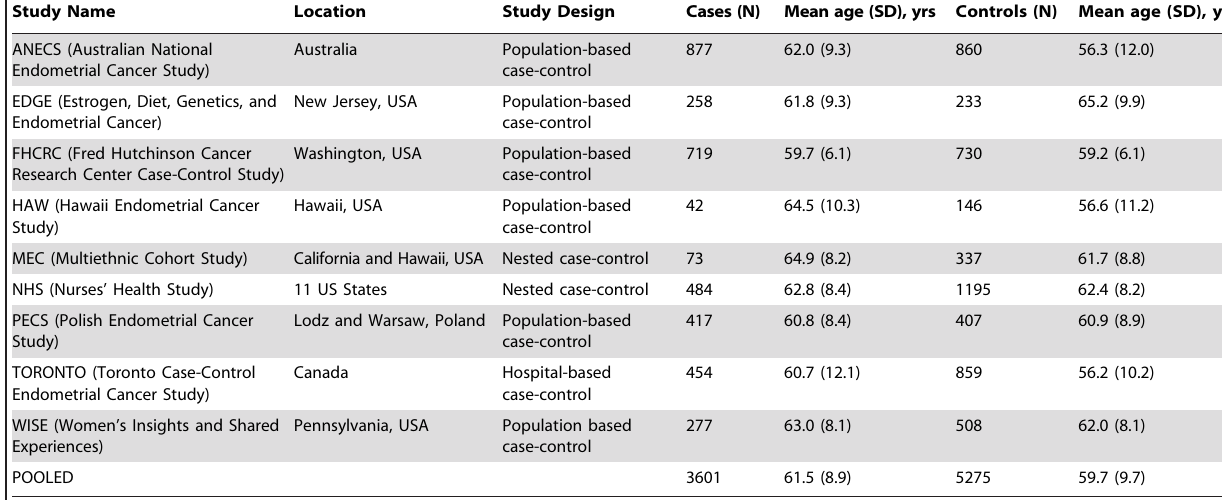
Table 4. Description of the studies included in the pooled analysis of FTO rs9939609 and MC4R rs17782313 and endometrial carcinoma